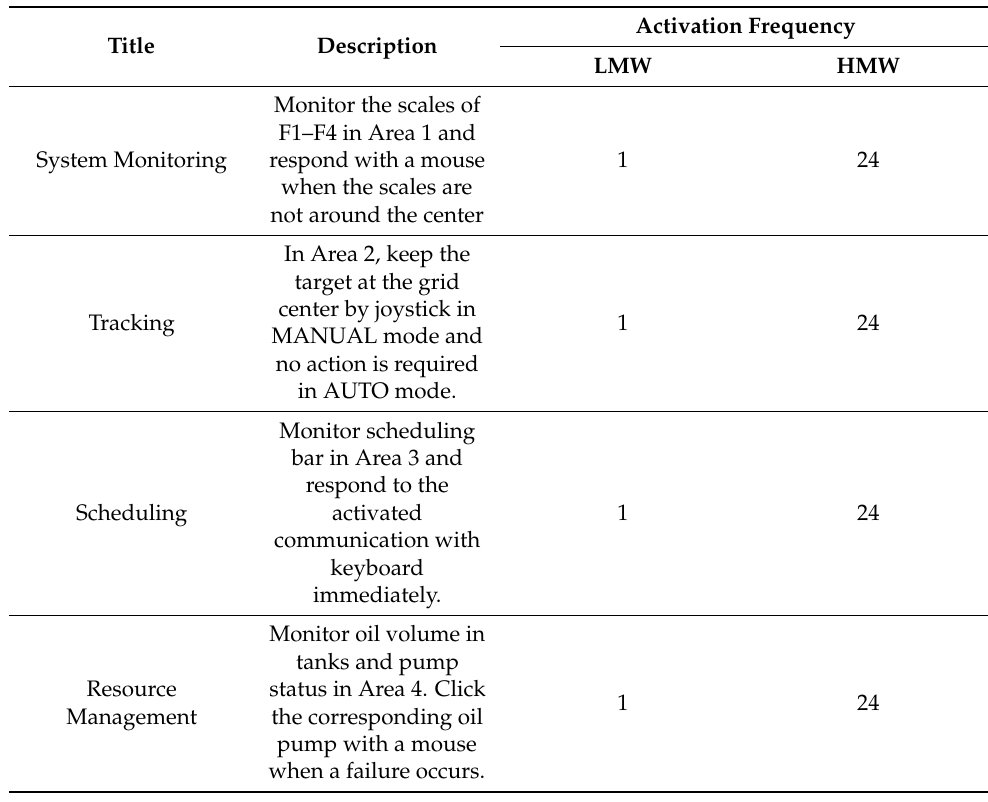
Table 1. Details of four